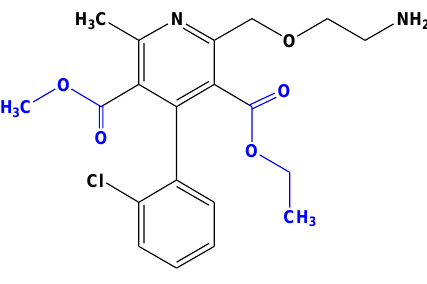
Figure 1. Chemical structures of amlodipine.